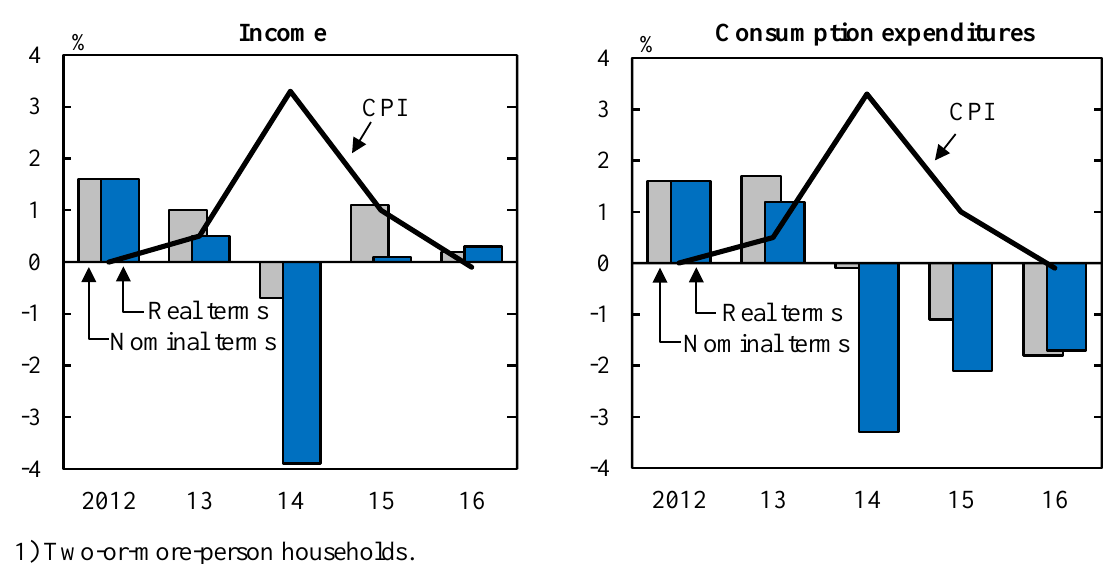
Annual Change in Household Income and Expenditures (Workers' households 1) )